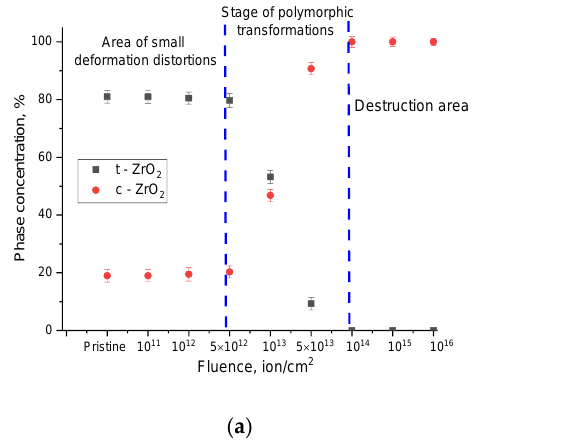
(1) where S peak — the areas of diffraction reflections, S background — the area of background radia- tion. In the initial state, the degree of crystallinity was more than 97%, which indicated a small contribution of amorphous or structurally disordered inclusions in the composition of the ceramics. The change in the degree of crystallinity of the surface layer with a